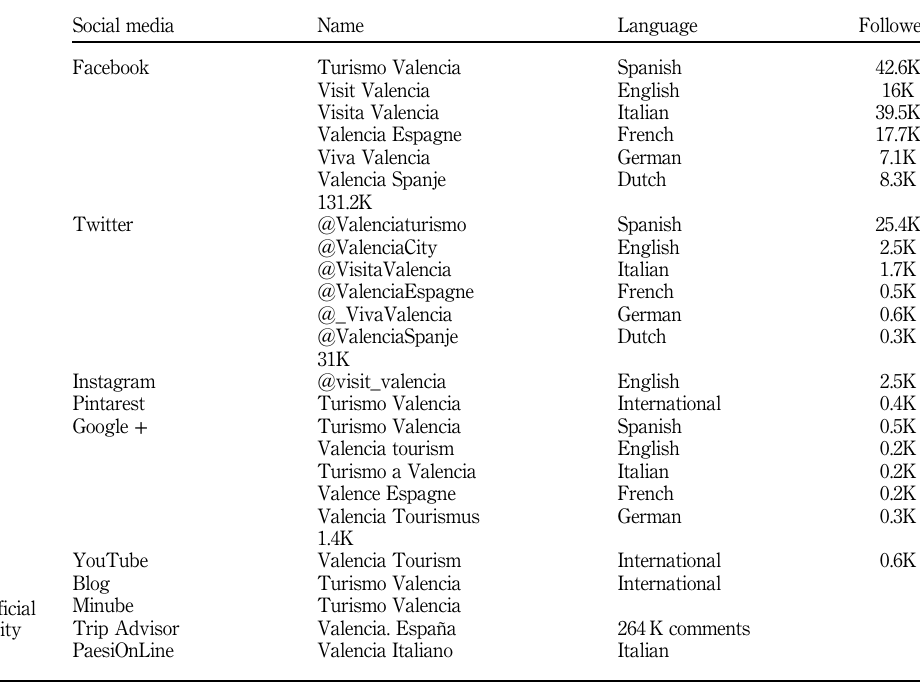
Table AI. Social media official profiles of the city of